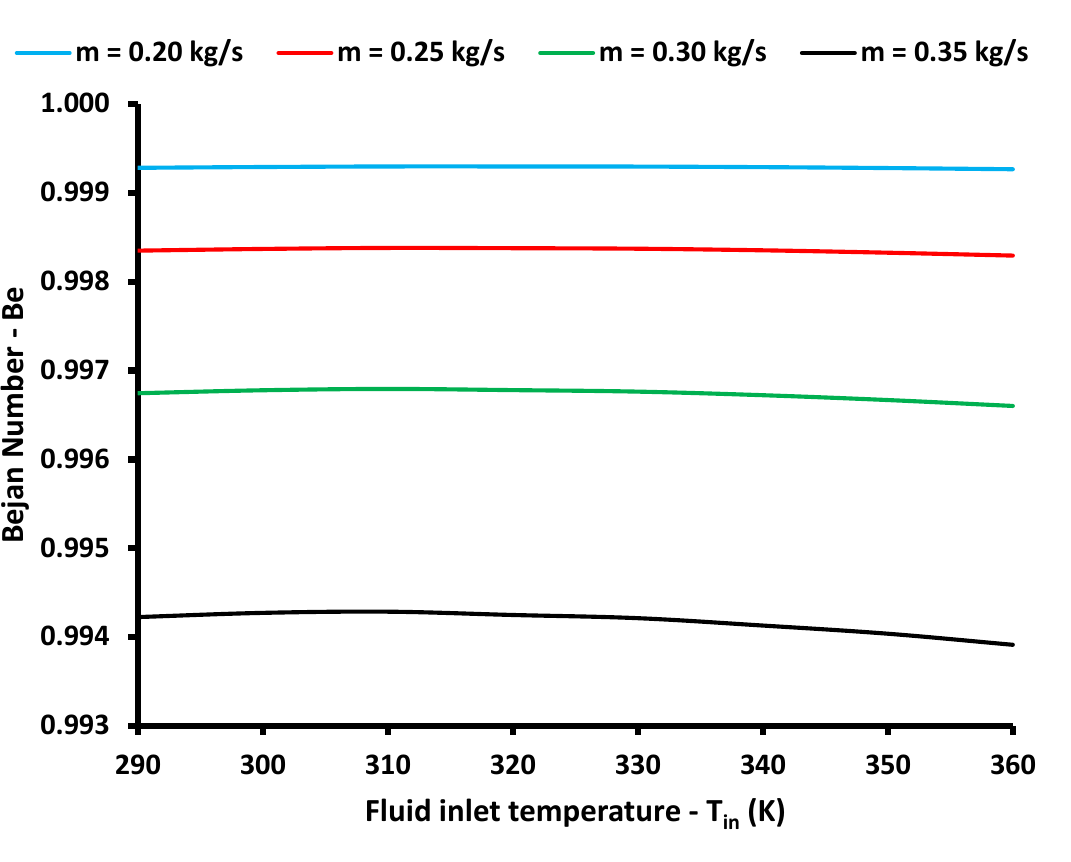
Figure 11. Pumping work demands variation for the different operating scenarios in the reference case of the empty tube.